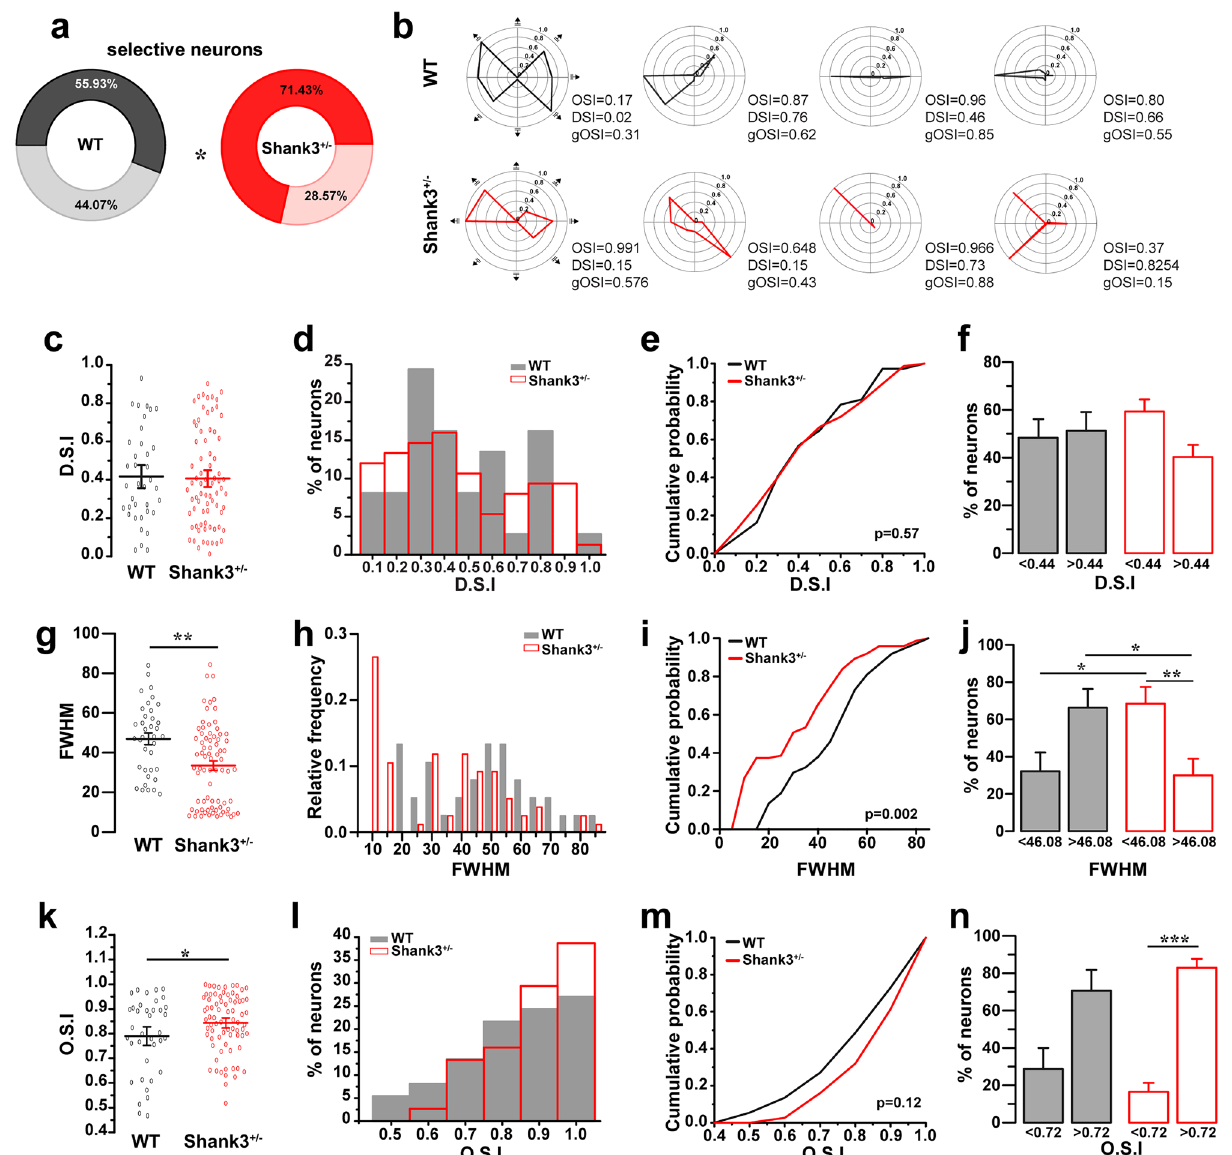
Figure 3. Orientation and direction tuning of V1 neurons from Shank3 +/− mice. ( a ) Proportion of selective and non-selective neurons from WT and Shank3 +/− mice (Fisher Exact test, * p = 0.030). ( b ) Representative polar plots of individual neurons from WT and Shank3 +/− mice. Bottom right O.S.I: orientation selectivity